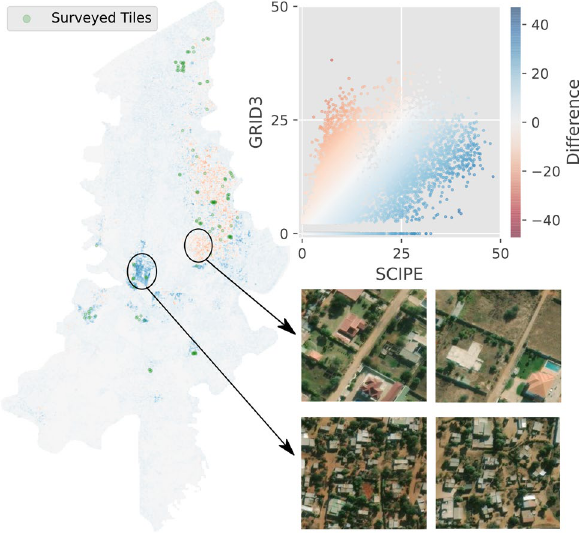
Figure 4. Clockwise from left: Difference between SCIPE and GRID3 population maps for Boane, the respective scatter plot, and examples of survey tiles from regions where they differ.